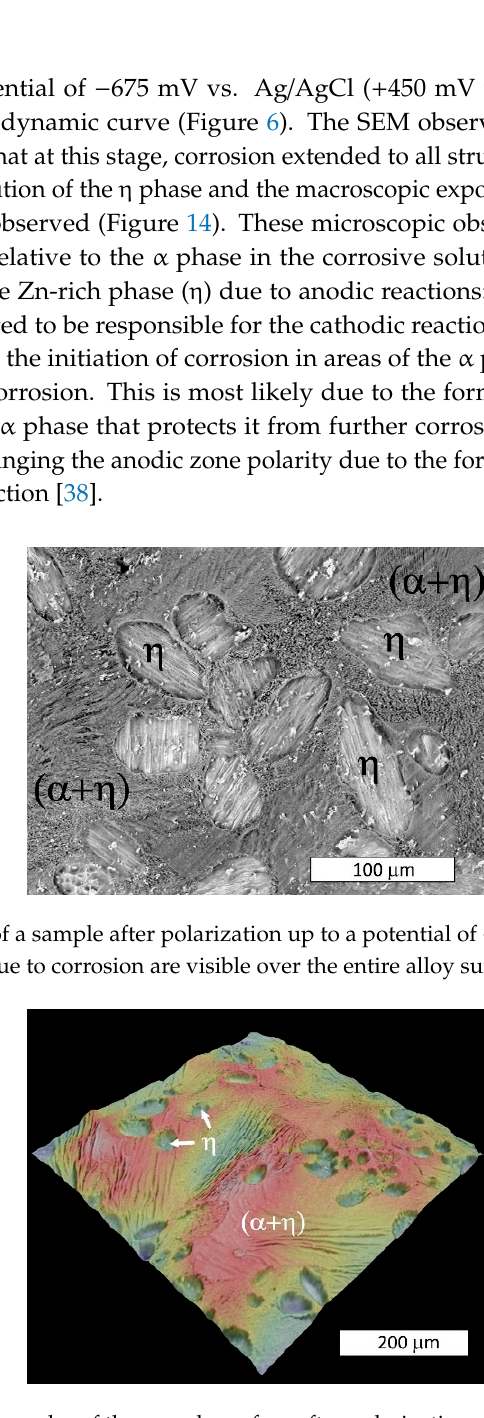
Figure 12. SEM and EDX images showing the distribution of elements on the sample surface after polarization up to the potential +300 mV vs. E corr : ( a ) SEM image merged with zinc and aluminum, ( b ) zinc, ( c ) aluminum, ( d ) oxygen. Element-rich areas are darker in the image.